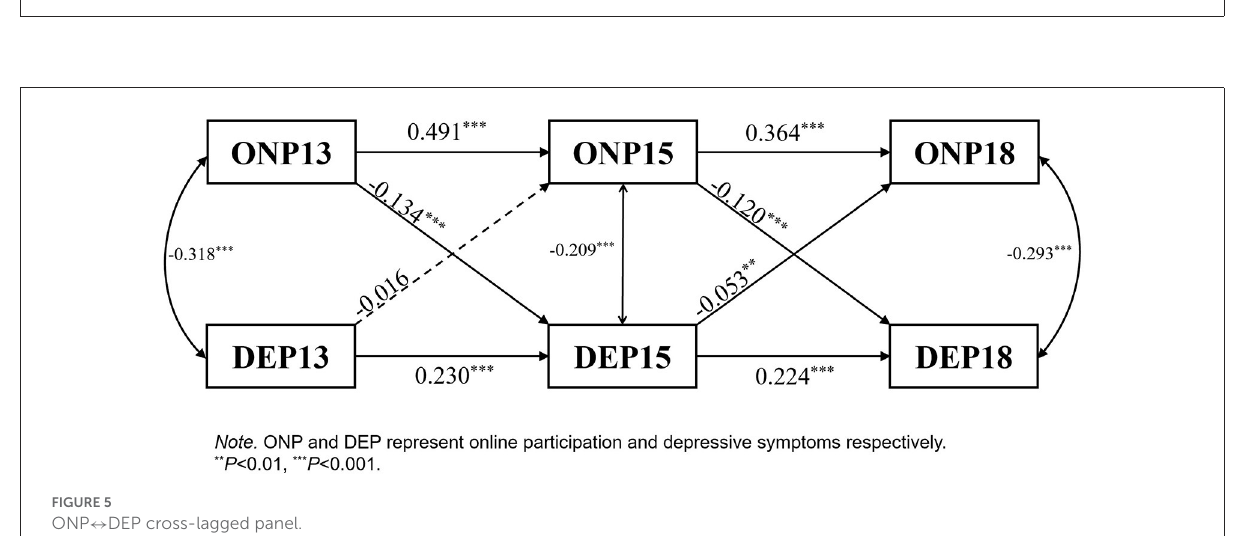
FIGURE4 OFP ↔ DEP cross-lagged panel.